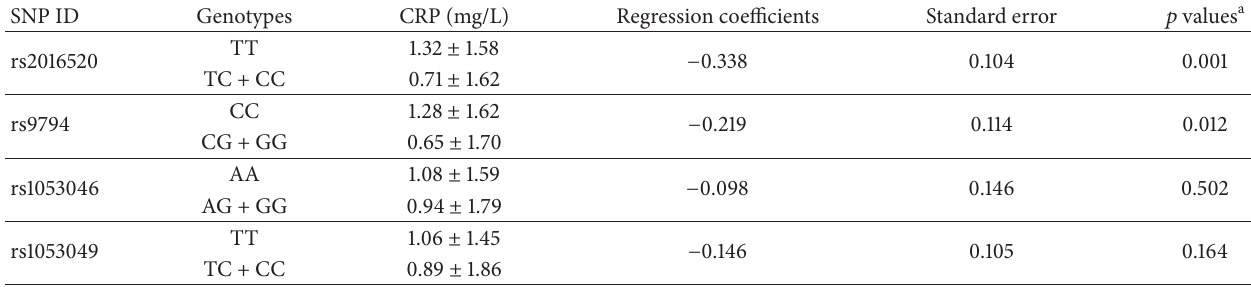
Table 3: Line regression analysis on association between 4 SNPs and CRP level.